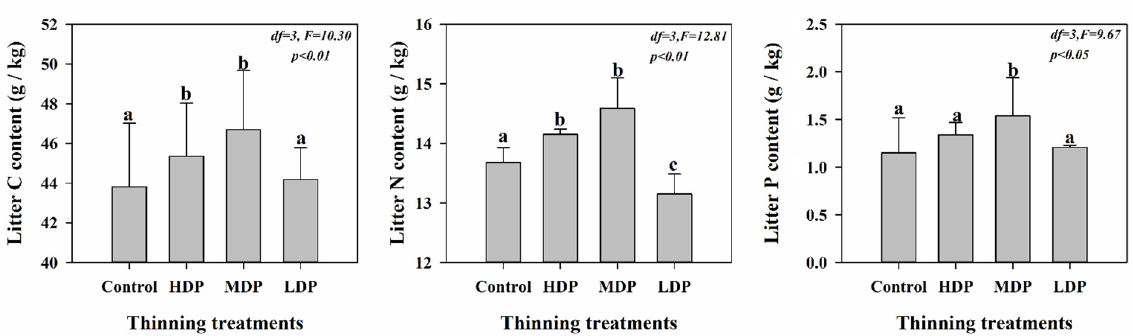
Figure 1. Characteristics of litter layer in L. principis-rupprechtii plantations with different density. Error bars indicate standard error ( n = 3). Different lowercase letters: p < 0.05, significant difference between treatments.